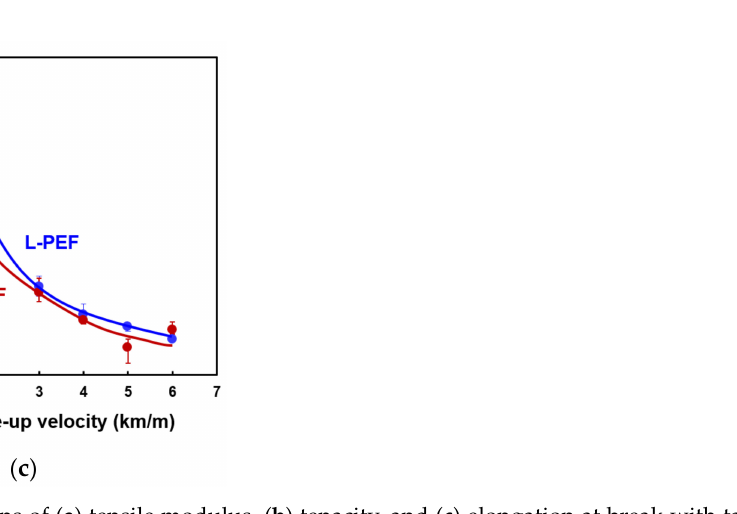
Figure 9. Variations of ( a ) tensile modulus, ( b ) tenacity, and ( c ) elongation at break with take-up velocity for high-speed spun L-PEF and H-PEF fibers.